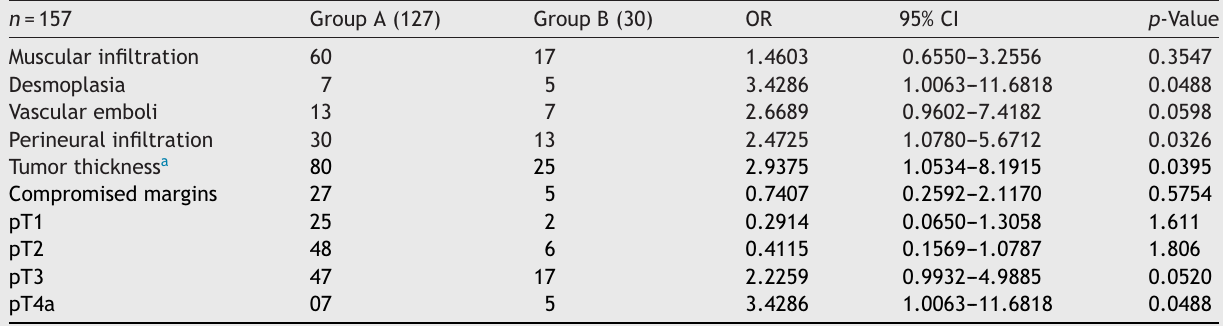
The incidence of the studied factors in both groups, odds ratio, confidence interval and p